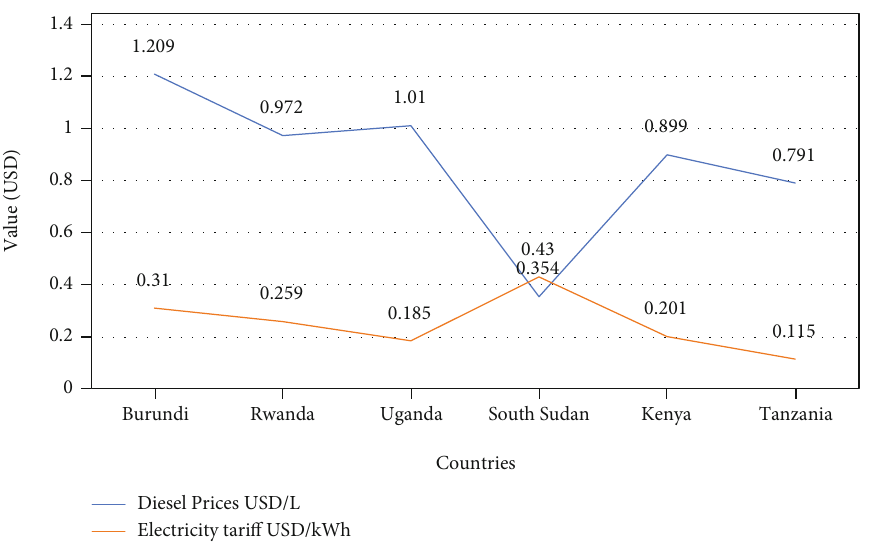
Figure 6: Diesel prices (USD/L) and electricity tari ff (USD/kWh) for the six EAC countries.